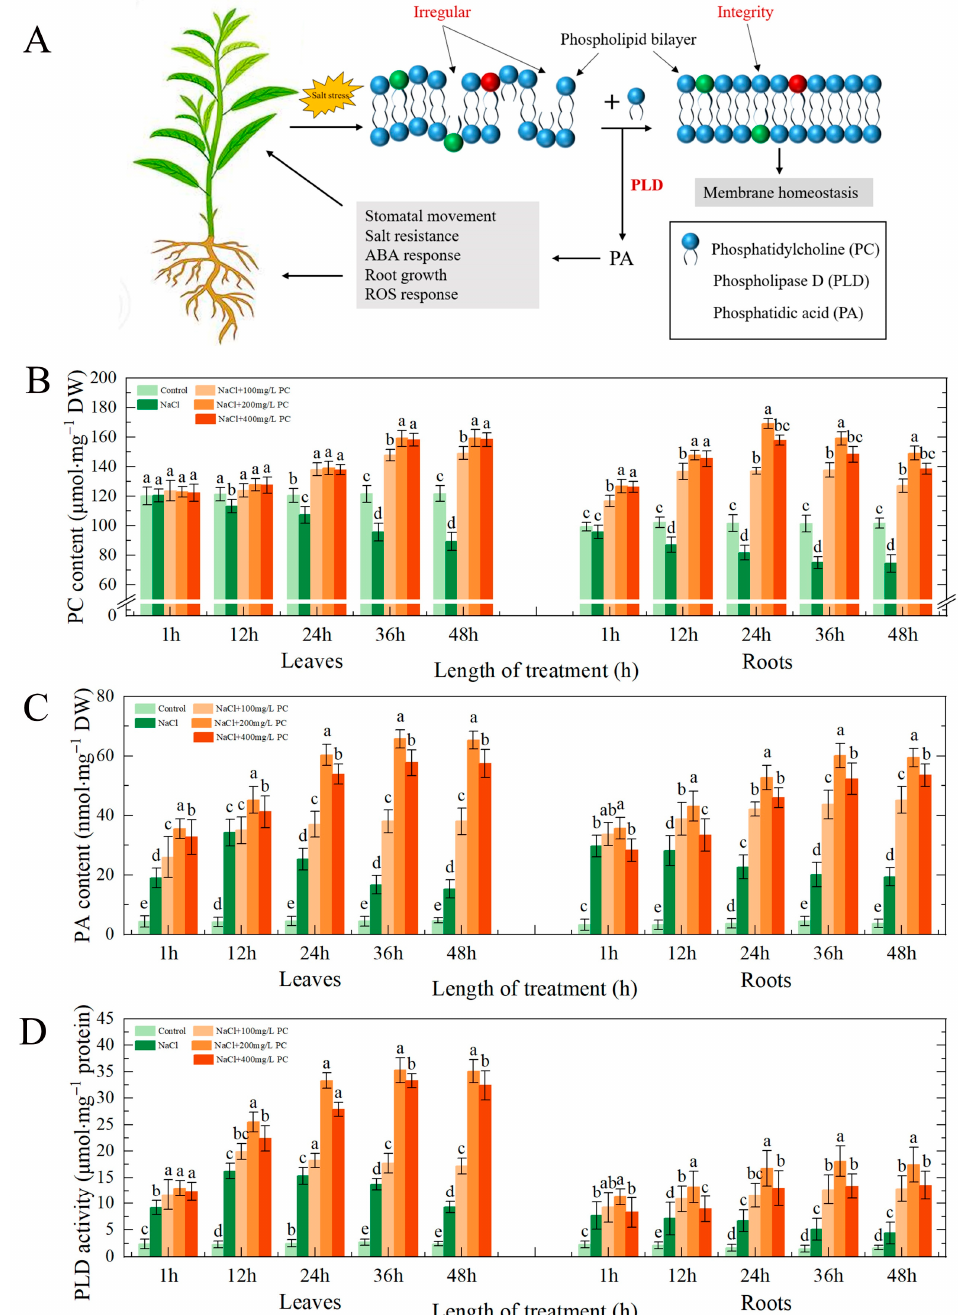
Figure 5. Cell membrane structure, PC, PA content, and PLD activity. ( A ) Effect of salt stress on the phospholipid bilayer of the plant cell membrane; ( B ) PC content; ( C ) PLD activity; ( D ) PA content. The error bar represents the standard deviation of the mean ( n = 3). Different lowercase letters indicate significant differences among treatments (Duncan test, p < 0.05).